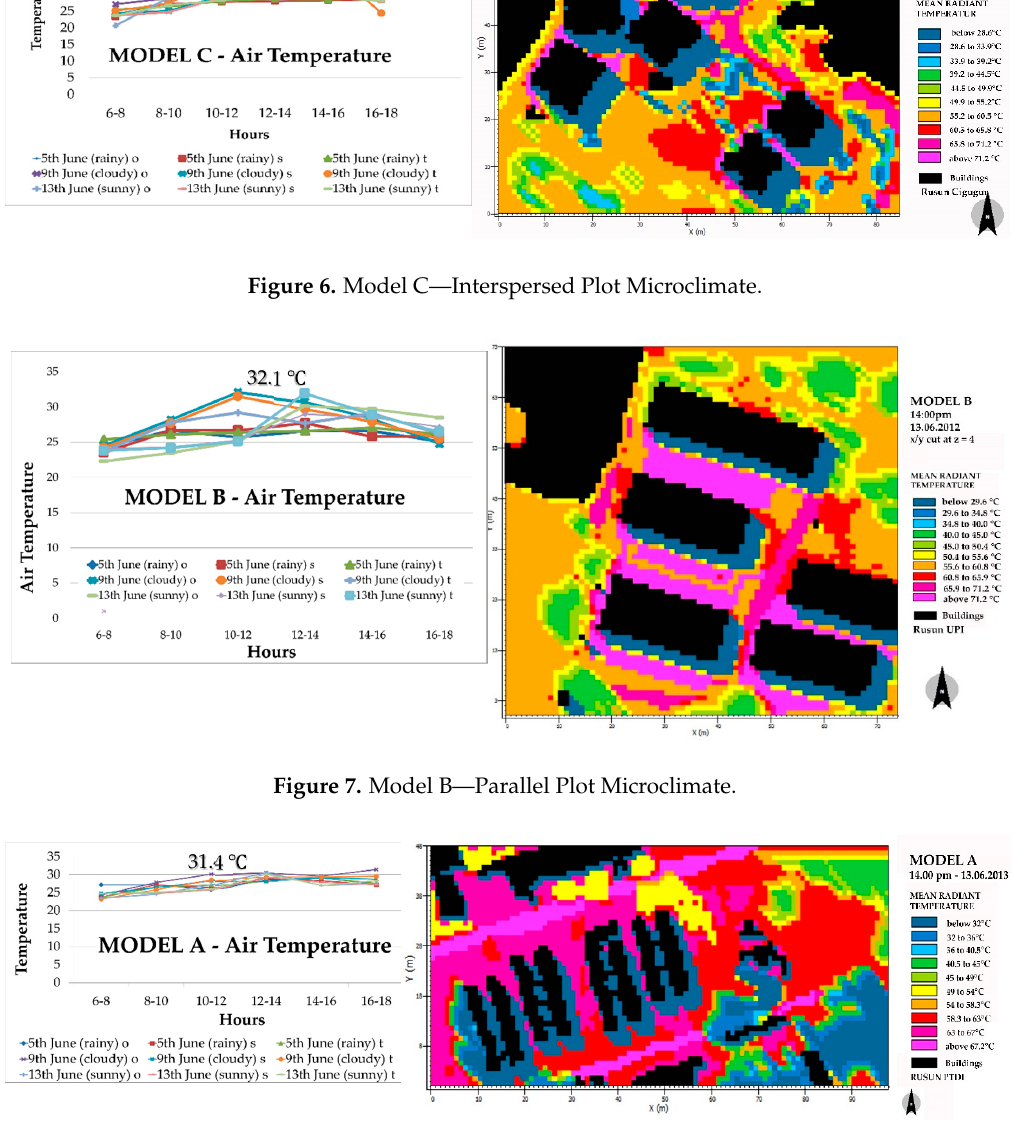
Figure 8. Model A—Parallel Plot Microclimate.